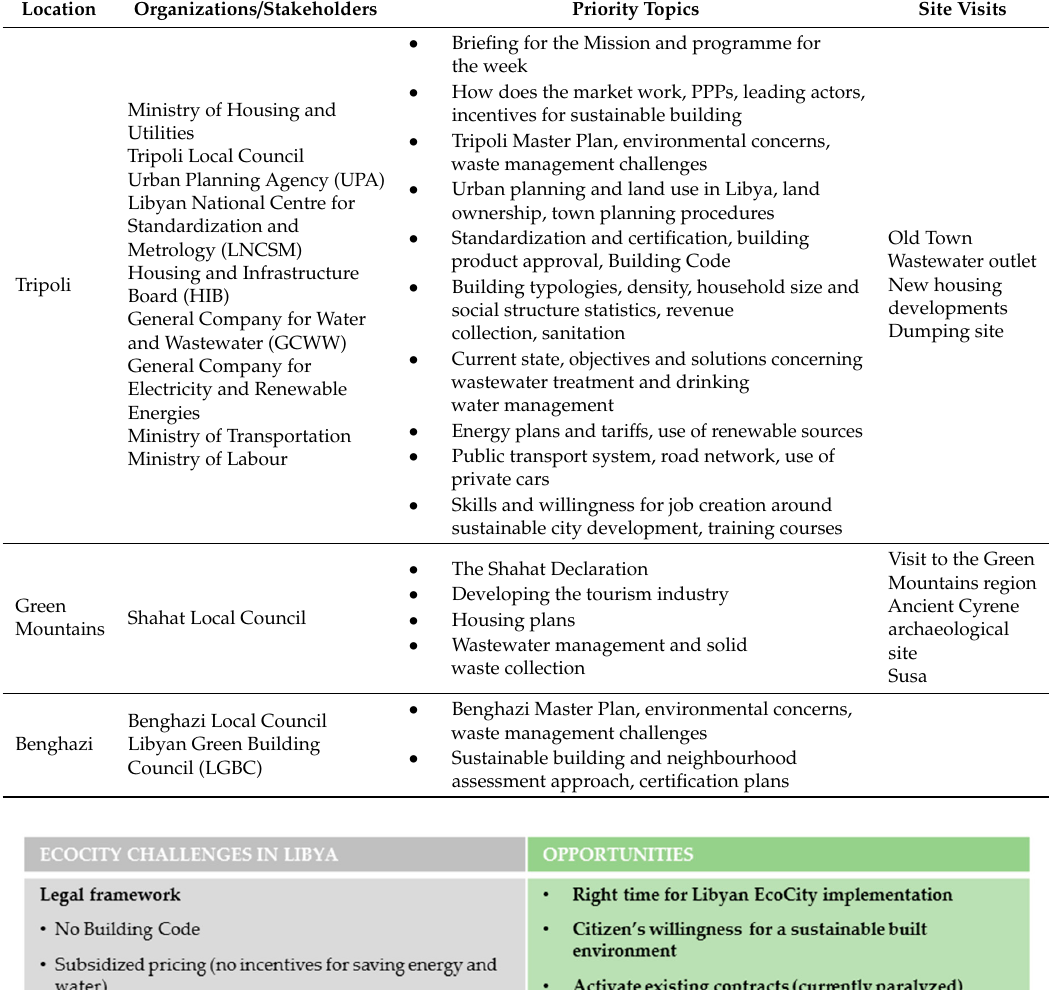
Table 1. Summary of meetings and site visits carried out during the Fact Finding Mission. (Carmen Antuña-Rozado, 2018).